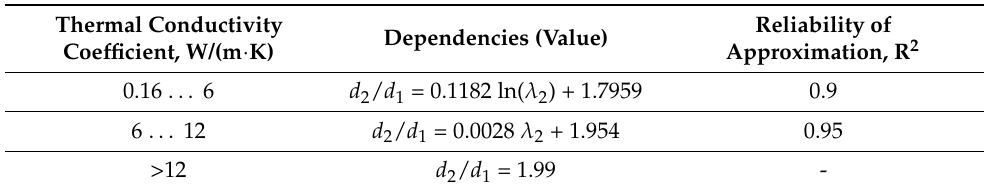
Table 3. Dependencies of d 2 /d 1 change on thermal conductivity of the thermal flowmeter tube material (provided that the influence of its radial heat flux on the axial heat flux is reduced).